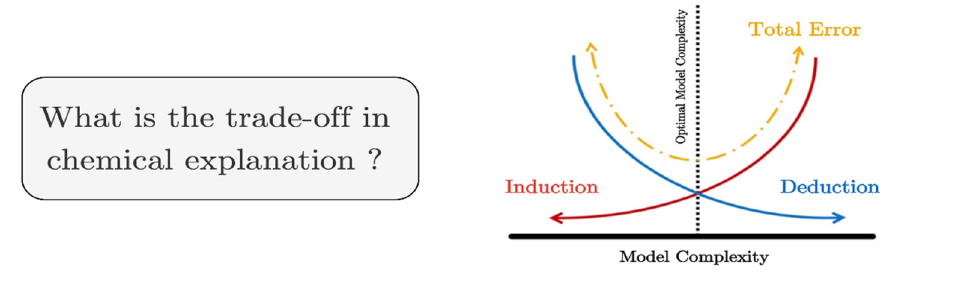
Figure 3. Illustration of the argument for a trade-off for a quasi-logic discovery in